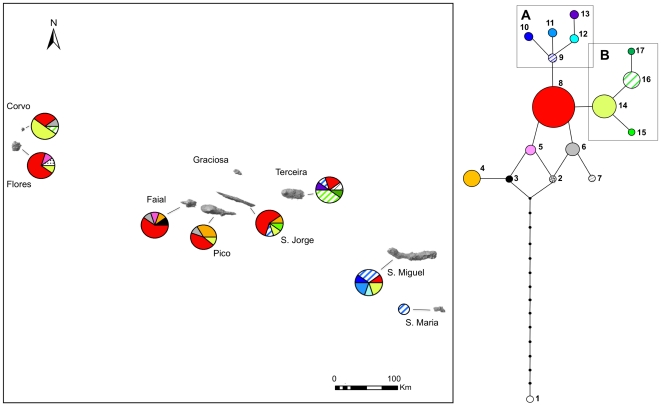
cpDNA (petN-psbM/trnS-trnG/trnT-trnL) haplotype network and its spatial distribution in the Azores archipelago.Each haplotype is represented by both a number and a color. Haplotype sizes are proportional to the number of individuals displaying them. Distinct clades (A and B) are shown within boxes.